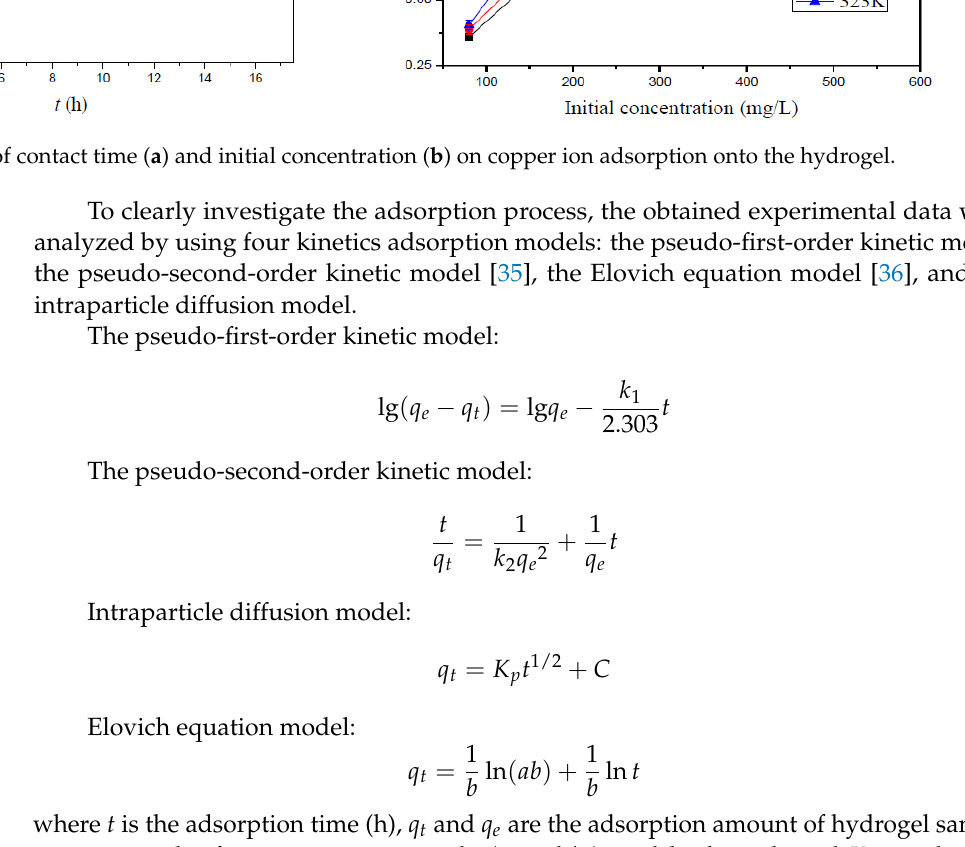
Figure 8. Plots of the pseudo-first-order model ( a ), pseudo-second-order model ( b ), intraparticle diffusion model ( c ), and elovich equation ( d ). Table 1. Kinetic parameters for copper ion adsorption on the prepared hydrogel.